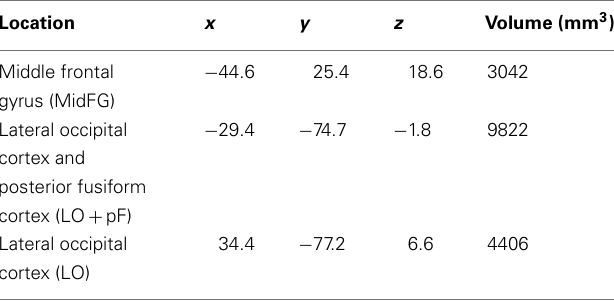
FIGURE 4 | Brain regions selective for uncertainty condition. We pooled the 80/20 and naive fMRI datasets across all subjects and searched for regions with a significant ( p < 0.05, corrected) difference, of either sign,